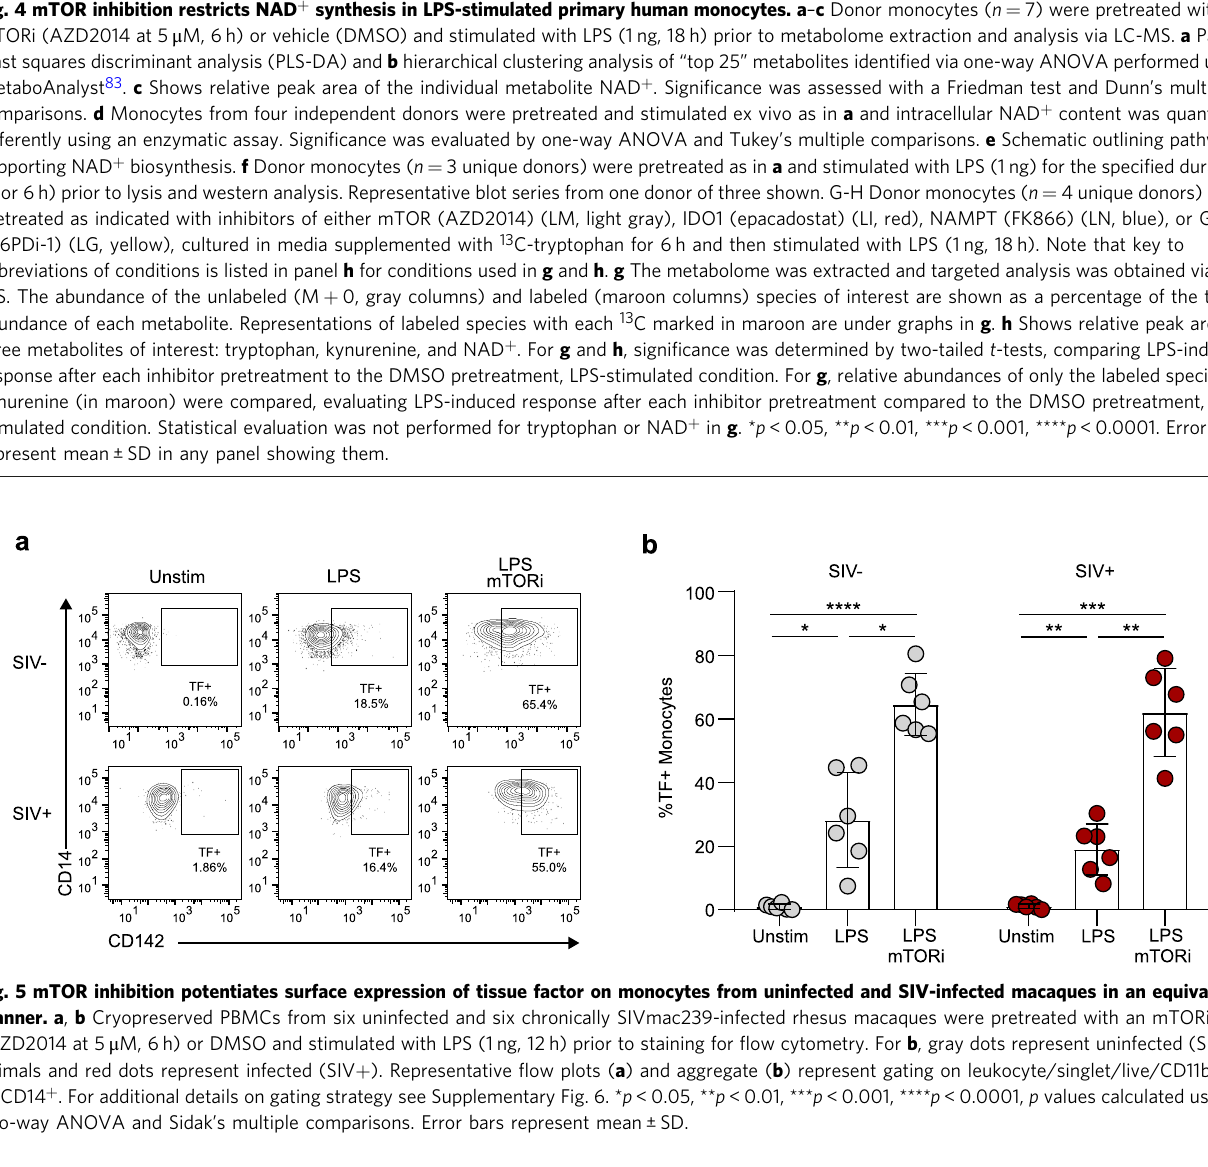
Fig. 4 mTOR inhibition restricts NAD + synthesis in LPS-stimulated primary human monocytes. a – c Donor monocytes ( n = 7) were pretreated with an mTORi (AZD2014 at 5 μ M, 6 h) or vehicle (DMSO) and stimulated with LPS (1 ng, 18 h) prior to metabolome extraction and analysis via LC-MS. a Partial least squares discriminant analysis (PLS-DA) and b hierarchical clustering analysis of “ top 25 ” metabolites identi fi ed via one-way ANOVA performed using